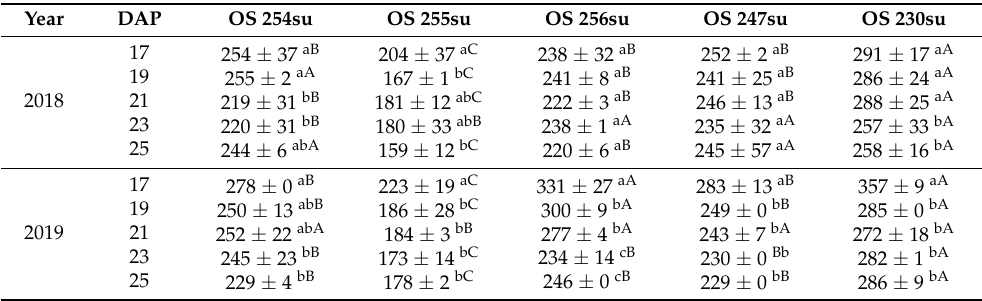
Table 5. Kernel total phenols content (mg GAE/100 g DW) in five su1 sweet corn hybrids at five harvest dates (17–25 DAP) in two growing seasons (Osijek, 2018 and 2019). The different lower- cases show significant differences among the harvest dates within hybrids ( p < 0.05). The different capital letters show significant differences among the hybrids ( p < 0.05).